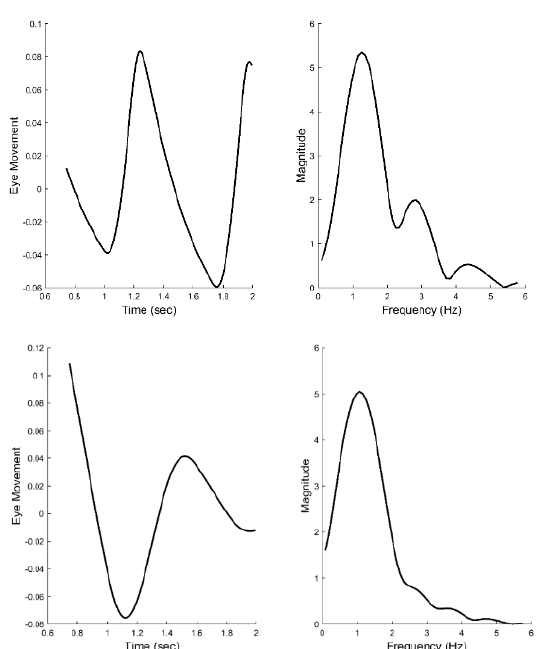
Figure 12: Time responses of model simulations of the slow component response (left-hand plots) and their associated spectral curves (right-hand plots). Only two model parameters were adjusted to produce these two different spectra, the feedforward gain and the derivative gain. The spectra have the same general shape as the those obtained from experimental data and shown in Figure 6. Recall, the two spectra shown in Figure 6 represent the range of shapes found in the experimental